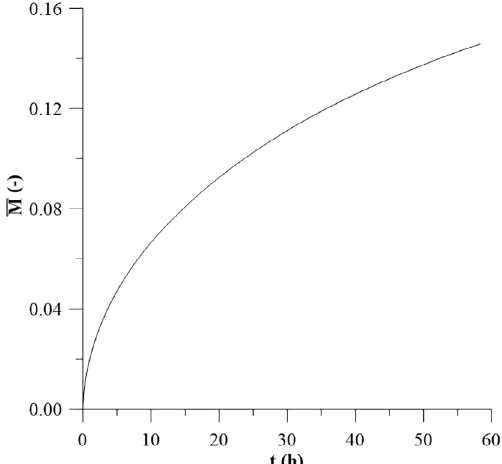
Figure 4. Kinetics of the average moisture content in the composite.